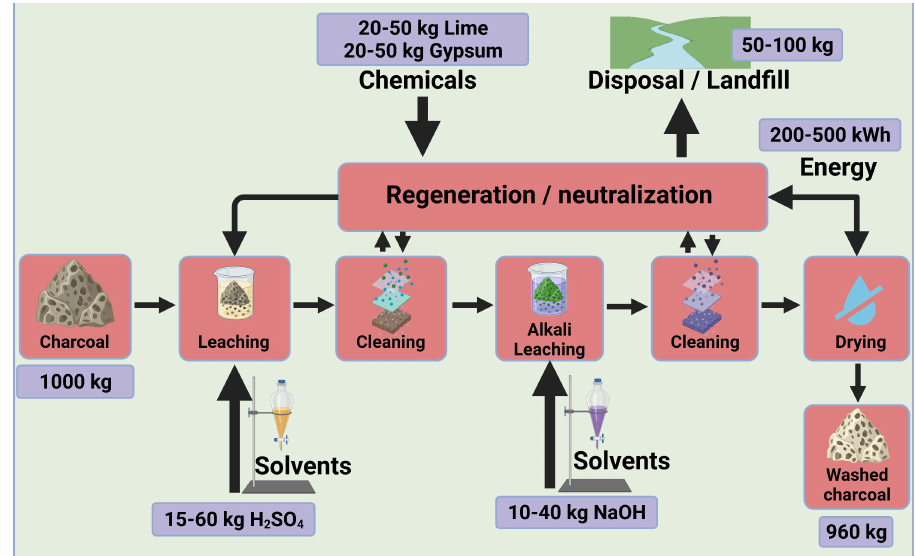
Figure 2. Flowsheet of the ash removal from charcoal.